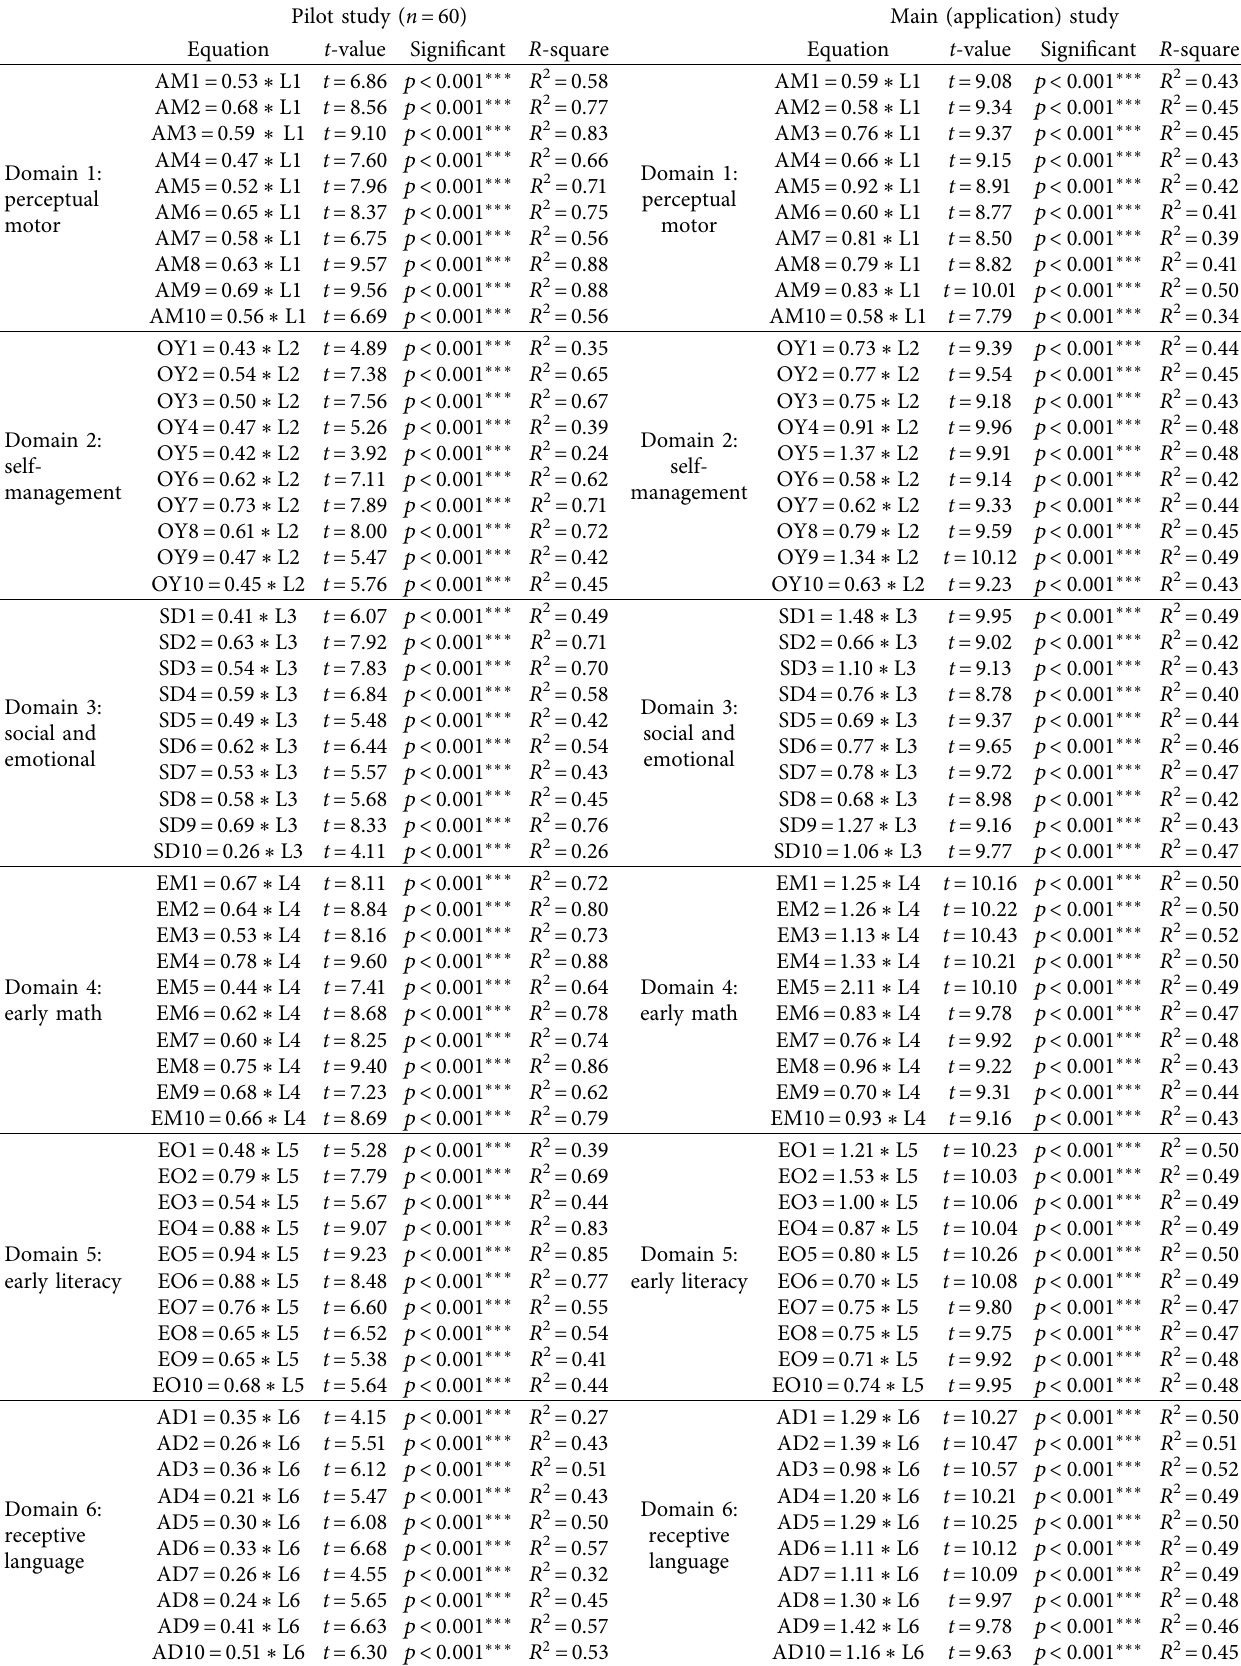
Table 4: Statistical results of path diagram obtained from confirmatory factor